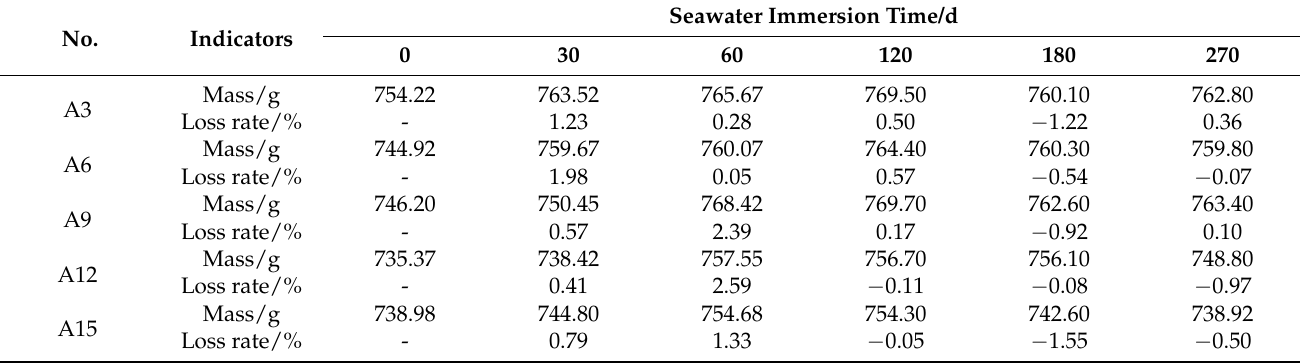
Table 8. Mass change of Group A.